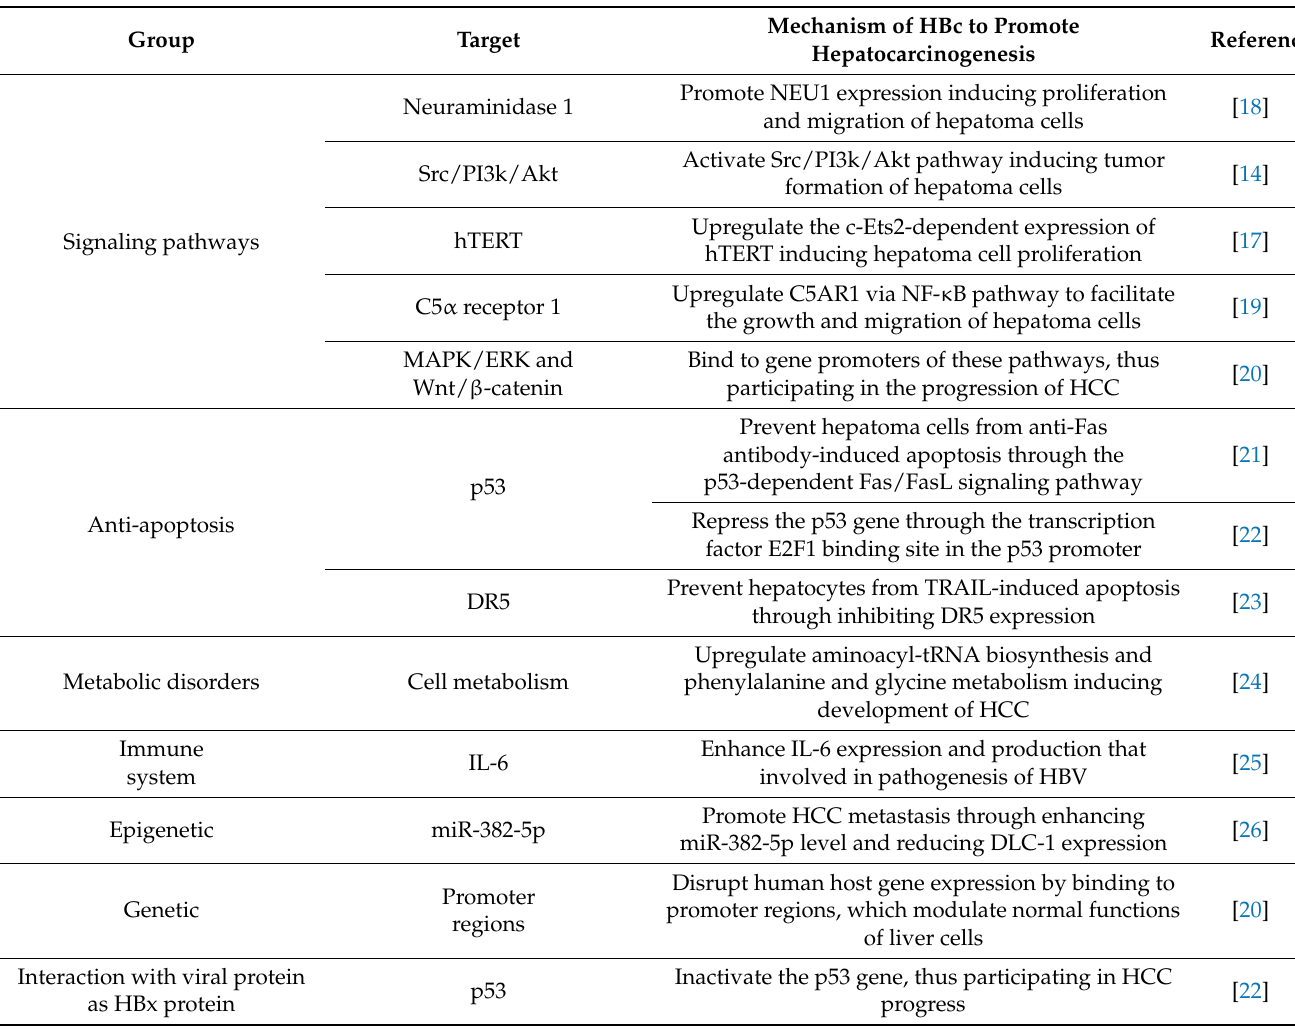
Table 1. Interactions and reported mechanisms of HBc protein on the various pathways (signaling pathways involved in migration and proliferation of hepatoma cells, apoptosis pathways, metabolic disorders, immune system), epigenetic and genetic